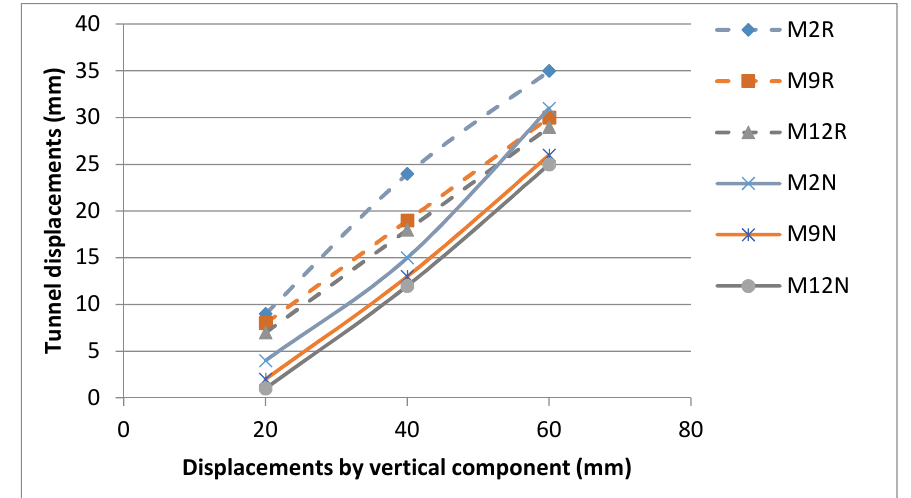
Figure 5. The effect of water content in reverse and normal faults. Figure 5. The e ff ect of water content in reverse and normal